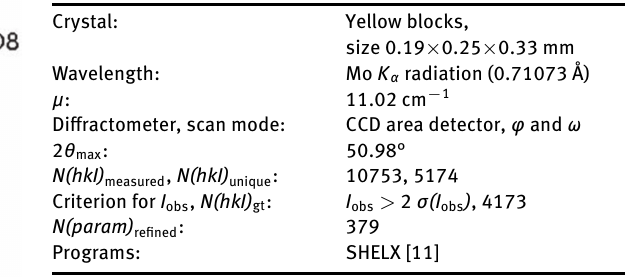
Table 2: Atomic coordinates and displacement parameters (in Å 2